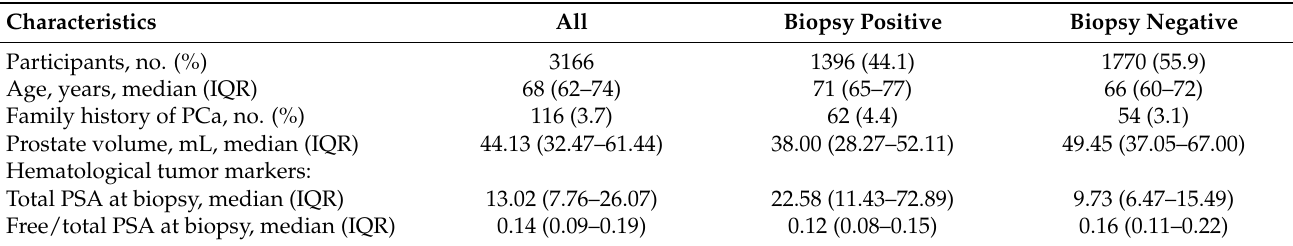
Table 1. Baseline descriptive clinical characteristics of the China biopsy